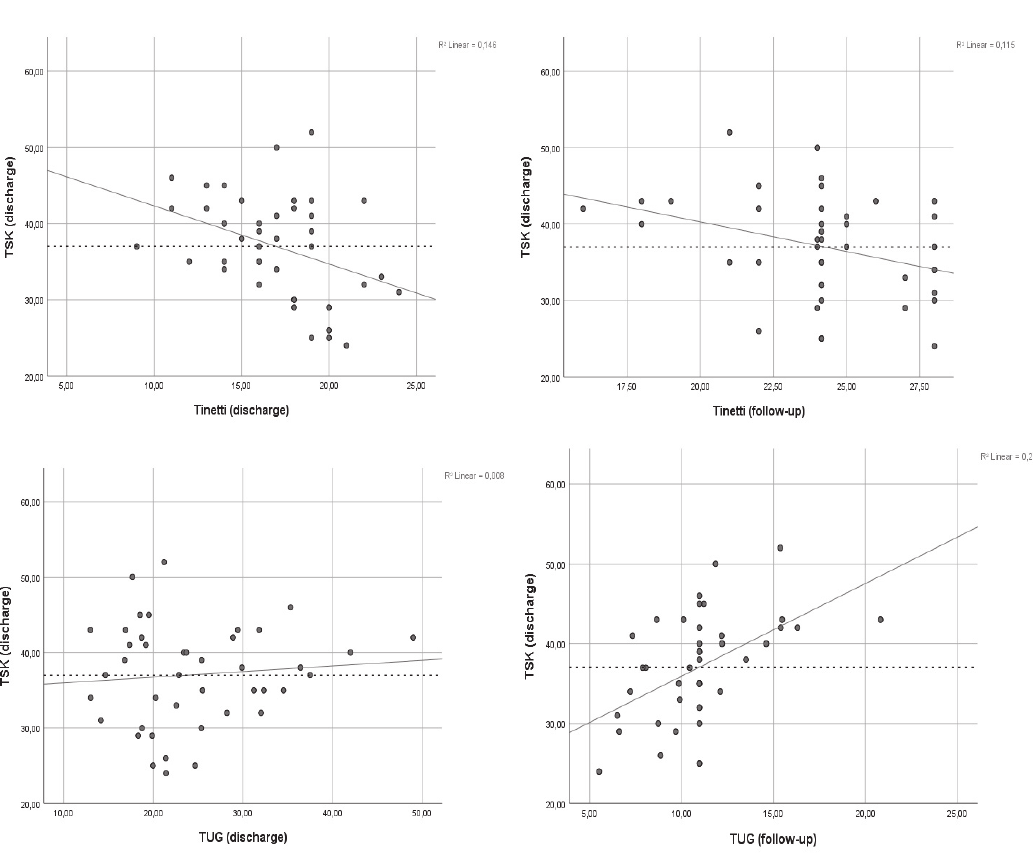
Figure 1. Scatter plots with regression line, showing the relation between TSK scores at time of discharge and PBM outcomes at discharge and follow-up.